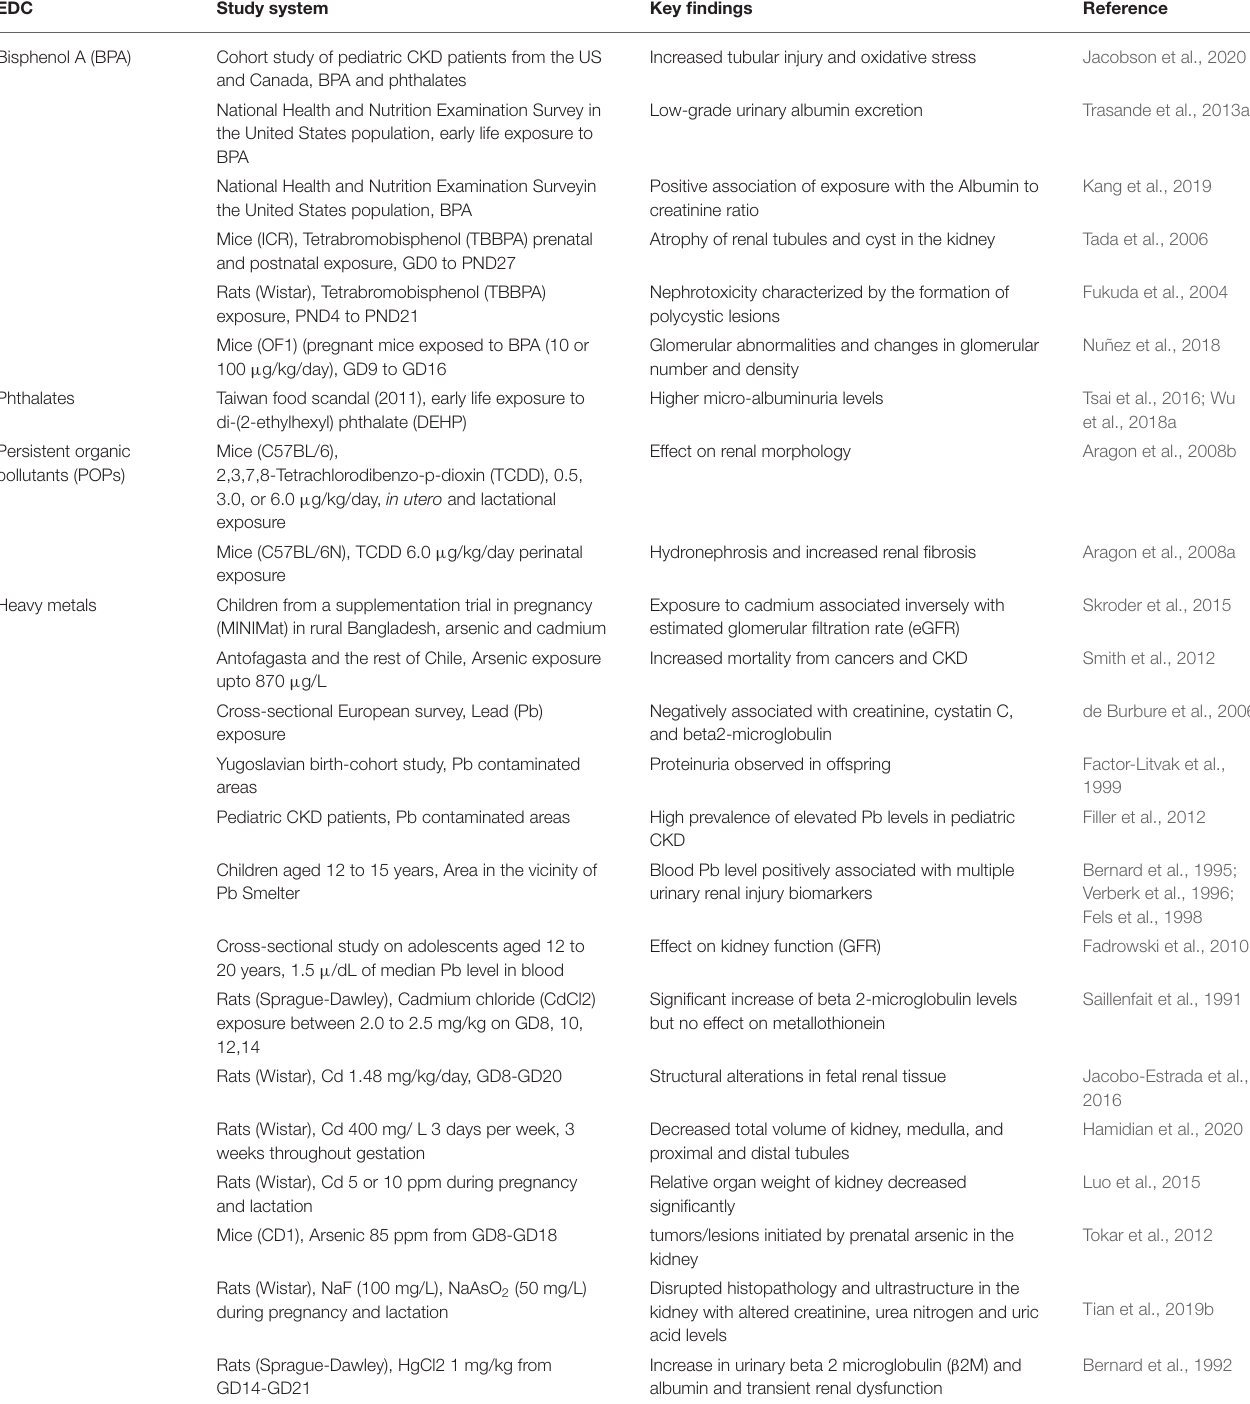
TABLE 3 | EDC exposure and renal